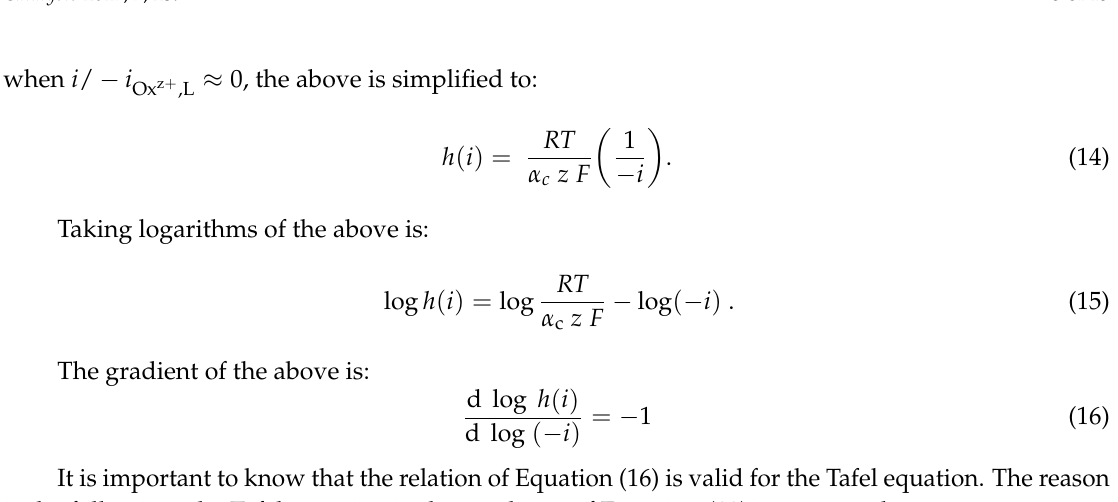
(cid:0) ∅ (cid:1) η and h ( i ). The symbols used